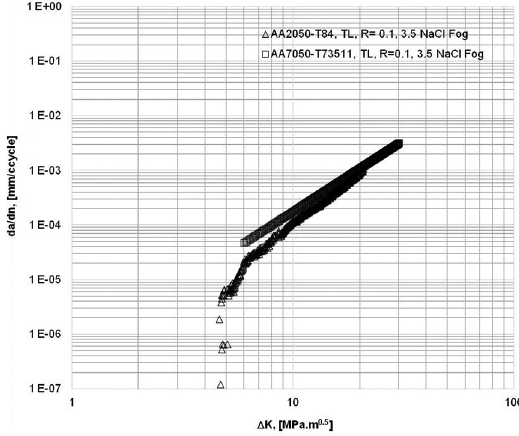
Figure 4. da/dN x ΔK curves for the AA2050-T84 Al-Li and AA7050-T7451 Al alloys tested in air, R = 0.1, 15Hz frequency, saline environment (3.5 wt% NaCl).